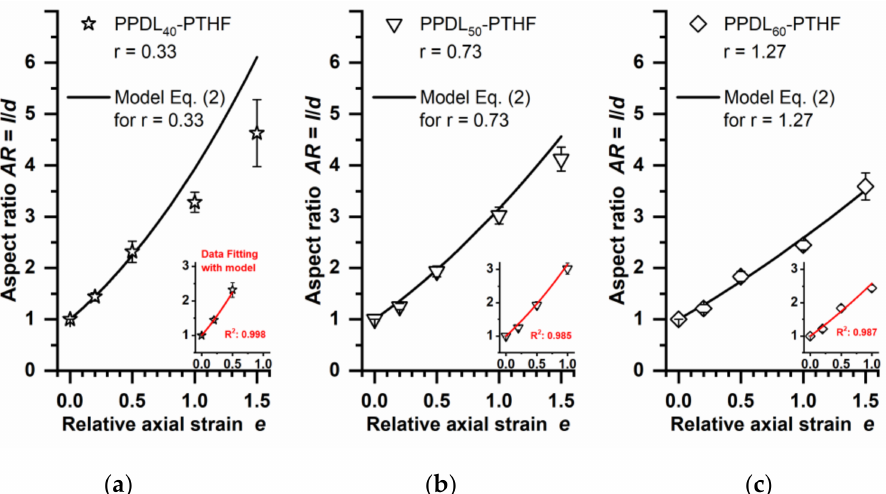
Figure 4. Correlation of experimentally determined AR and predictions of the heterogeneous defor- mation model according to Equation (2). Data for PPDL-PTHF particles after phantom stretching at different e (open symbols). Curve of the model as calculated based on the applicable r values (Table 1) for the respective PPDL-PTHF material (black lines). Insets: fitting of the model to experimental data up to AR values of ~3. ( a ) PPDL 40 -PTHF, ( b ) PPDL 50 -PTHF, and ( c ) PPDL 60 -PTHF. Mean and S.D. of n ≥ 20 particles for each condition. R 2 coefficient of determination from curve